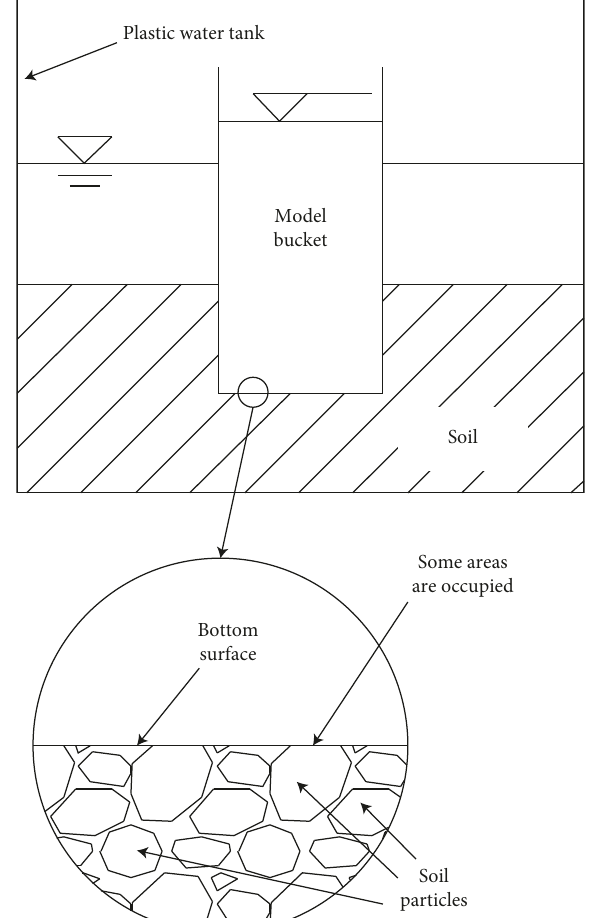
Figure 8: Local enlarged drawing of bottom surface of the model